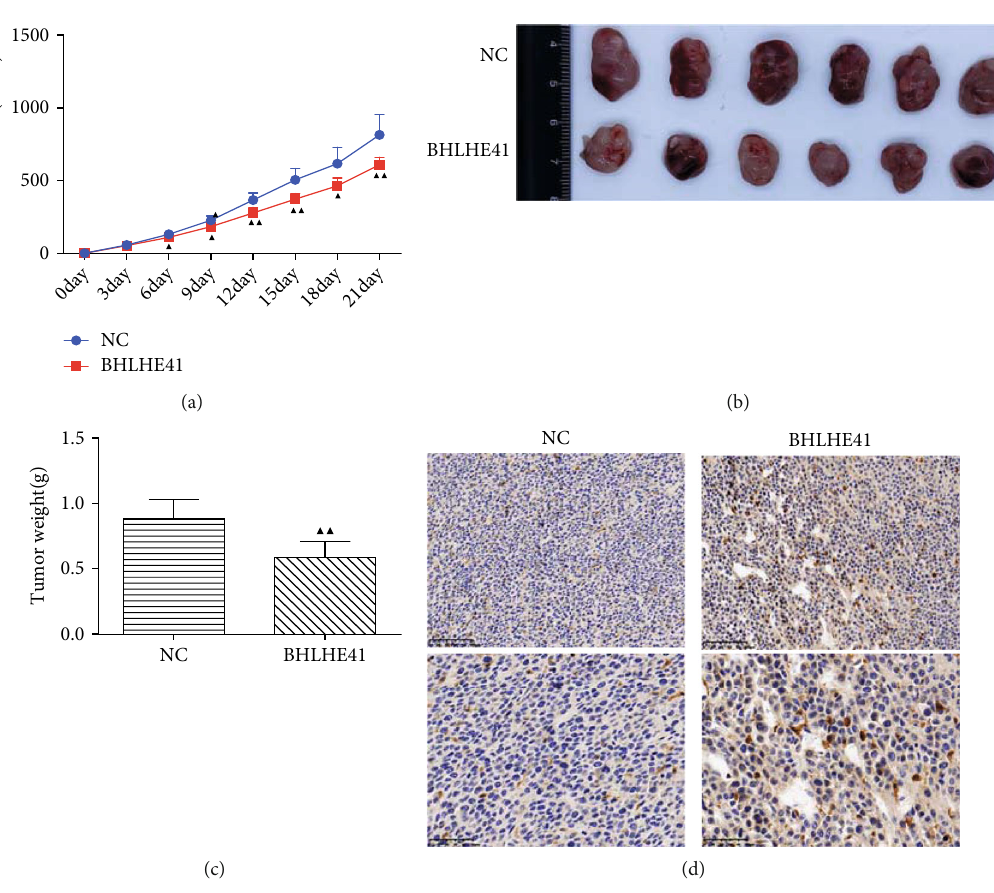
Figure 9: BHLHE41 overexpression attenuated tumor volume and weight and enhanced the positive expression of BHLHE41 in tumor tissues. (a) Tumor volume growth curve. (b) Tumor pictures of nude mice. (c) Tumor weight. (d) The positive expression of BHLHE41